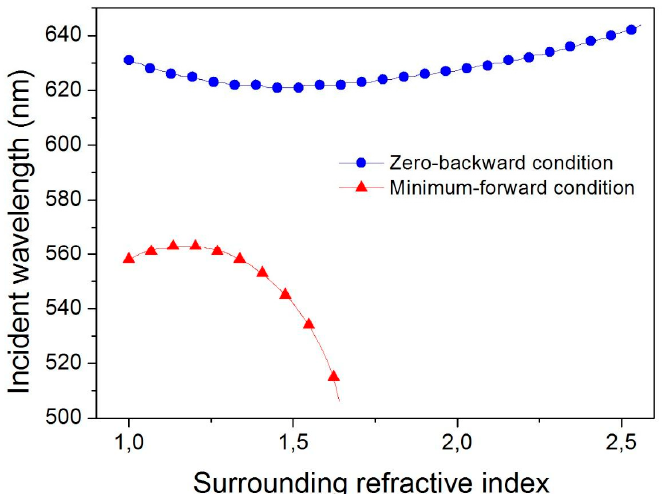
Figure 2. Comparison of the sensitivity of both directional conditions, the zero-backward and the minimum-forward scattering condition, with the external refractive index. The figure shows the incident wavelength at which any of the directional conditions are satisfied as a function of the refractive index of the surrounding medium. A Cu 2 O spherical particle with a diameter of 184 nm was considered in an ideal homogenous medium.